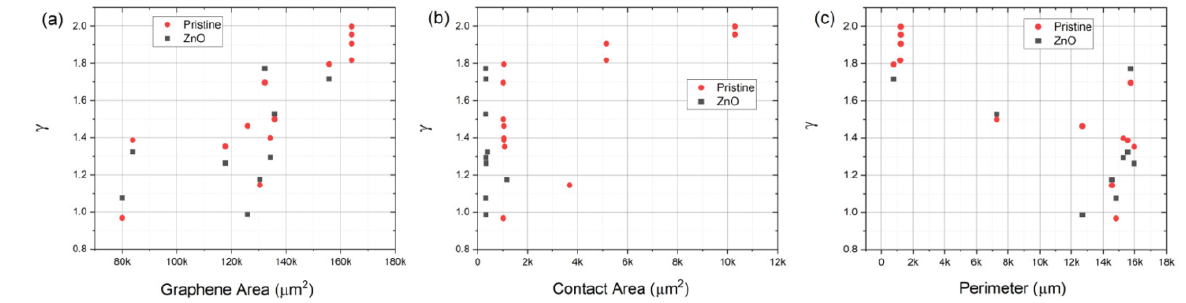
Figure 7. Frequency exponent γ plotted against ( a ) graphene area, ( b ) contact area, and ( c ) total perimeter for both pristine and ZnO functionalized graphene